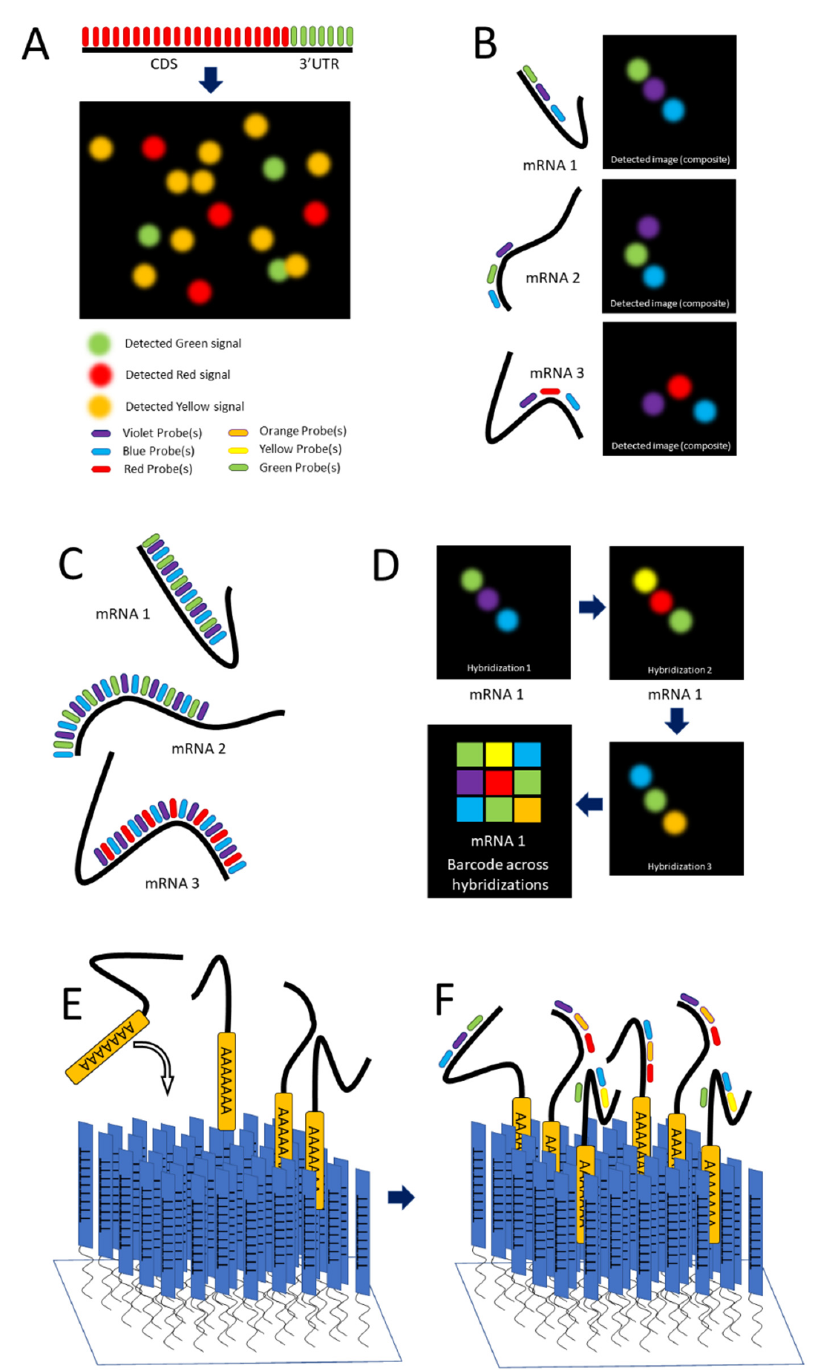
Figure 2. smFISH and seqFISH. ( A ) smFISH: Top, multiple probes of the same color designed to hybridize along the length of both the CDS and 3 (cid:48) UTR of the intended transcript; bottom, mRNAs imaged after hybridization, with yellow spots showing transcripts containing both the CDS and 3 (cid:48) UTR [after (Raj, 2008)]. ( B ) seqFISH Spatial barcoding, in which probes are designed to hybridize ~100 nt apart to facilitate resolution of unique combinations (after [71]). ( C ) Spectral barcoding, in which a color code of probes hybridizes repeatedly along the length of a transcript in order to increase its detectability and identifiability. ( D) Repeated cycles of hybridization, imaging, and removal of probes results in a temporal barcode that increases the number of unique barcodes possible and aids resolution via the temporal dimension (Panels C,D after [73]). © seqFISH in vitro: An oligo(dT) surface is created and mRNAs hybridize to it via their poly-A tail, spreading out to a resolvable distance. ( F ) Probes are hybridized to the adhered